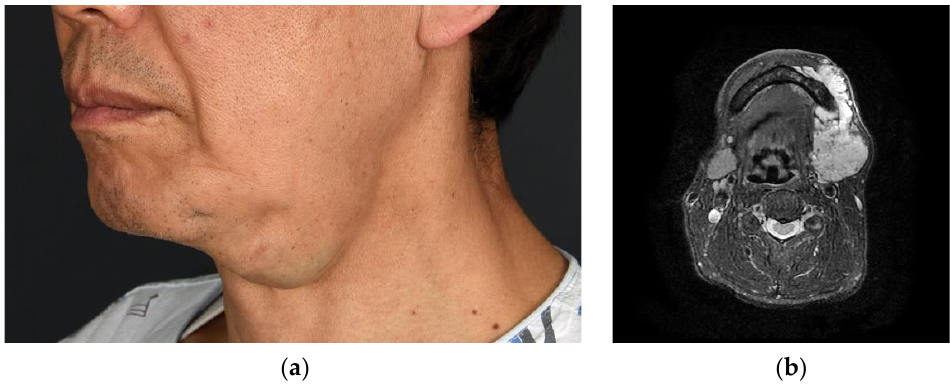
Figure 1. VM in the left submandibular area. ( a ) Bulging blueish vascular mass was observed; ( b ) MRI findings of VM. These T2-weighted with fat suppression MRI findings showed an infiltrative vascular channel with a size of 8.2 × 4.1 cm from the subcutaneous fat layer to the submandibular gland and part of the posterior belly of the digastric muscle in the left submandibular area. It showed inhomogeneous patchy high signal intensity inside. VM, venous malformation; MRI, magnetic resonance imaging.